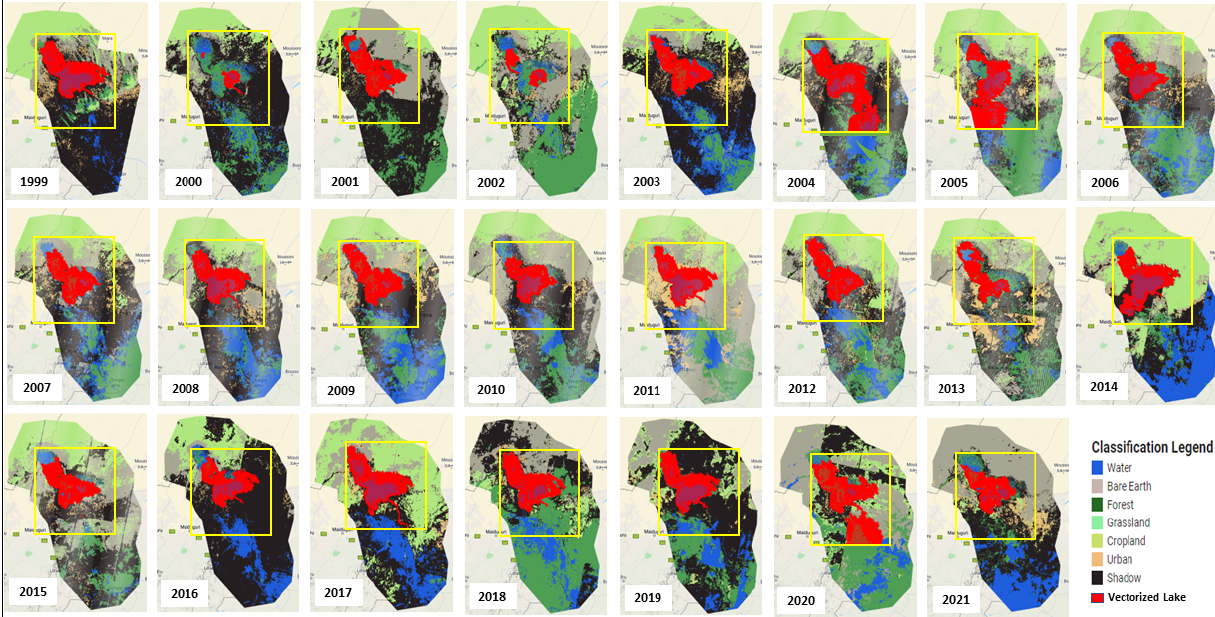
Figure 4. The Lake Chad surface water extent change through time. Vectorized lake of interest is in red, while the rest of unconnected pockets of water bodies are in blue. The rest of the features are represented with different colors in the image.